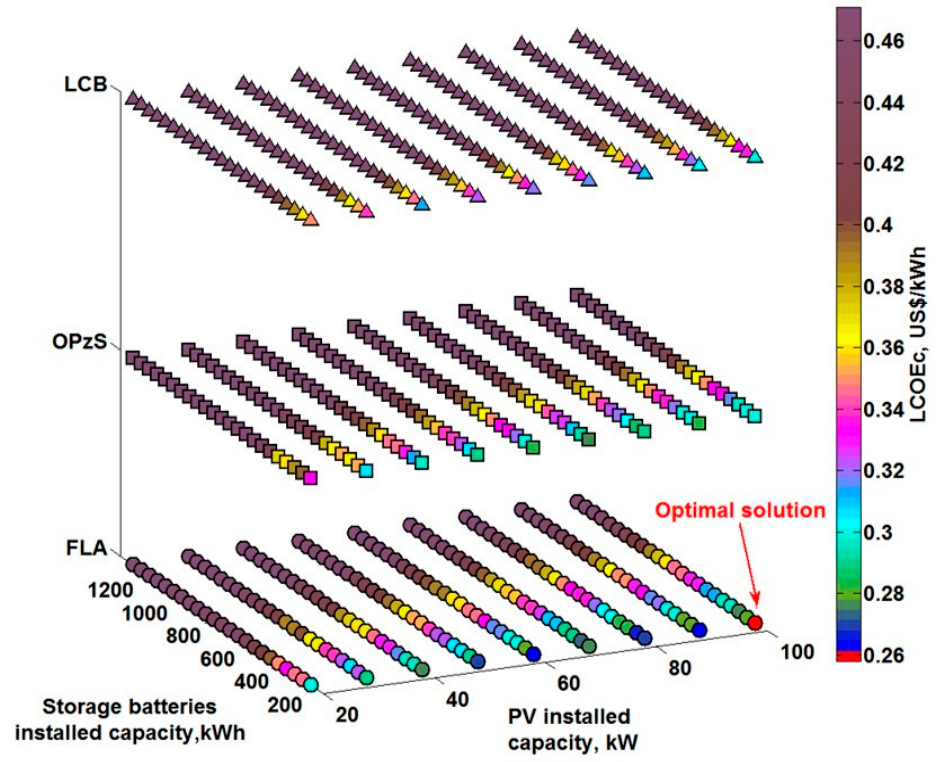
Figure 3. Changes in LCOE under energy service contracting according to the capacity of the pho- tovoltaic system with storage batteries. Table 1. Technical and economic parameters of the optimal technical solution.